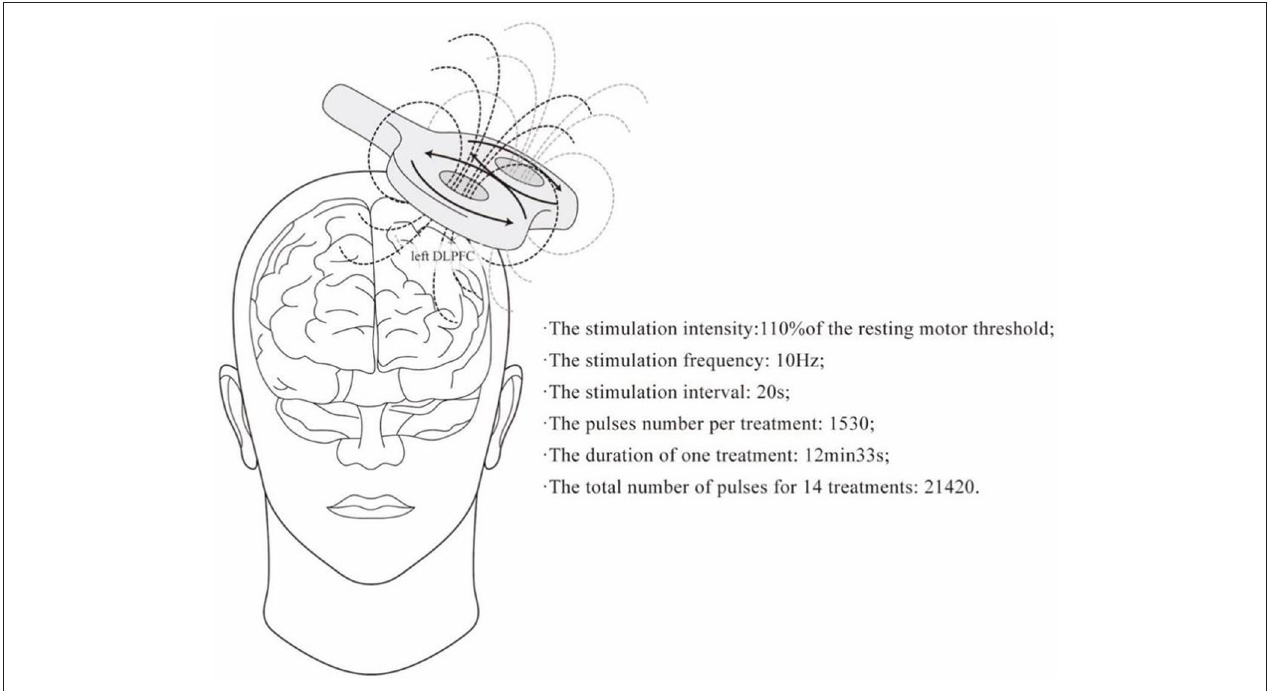
FIGURE 3 | Protocol and parameters of rTMS intervention.